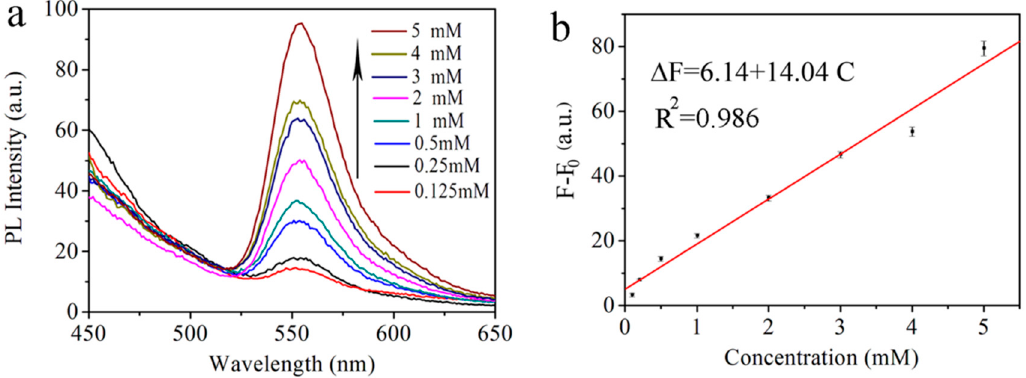
Figure 6. ( a ) Emission spectra of SiNPs-AuNPs in the presence of different L-Cys concentrations: 0.125, 0.25, 0.5, 1, 2, 3, 4 and 5 mM; ( b ) Linear relationship of L-Cys. The concentration of L-Cys is 0.125, 0.25, 0.5, 1, 2, 3, 4 or 5 mM, respectively.